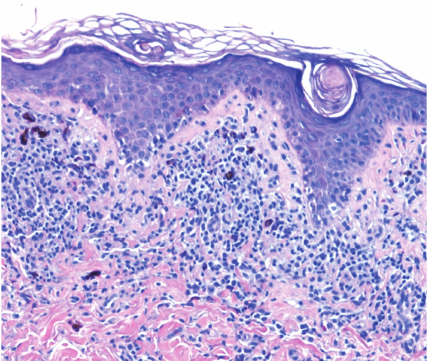
Figure 7: Lichen planus: there is a band-like infiltrate of lympho- cytes at the epidermal-dermal junction with damage to the basal cell layer and pigment incontinence. The epidermis has a saw-toothed appearance (hematoxylin-eosin, original magnification × 200).